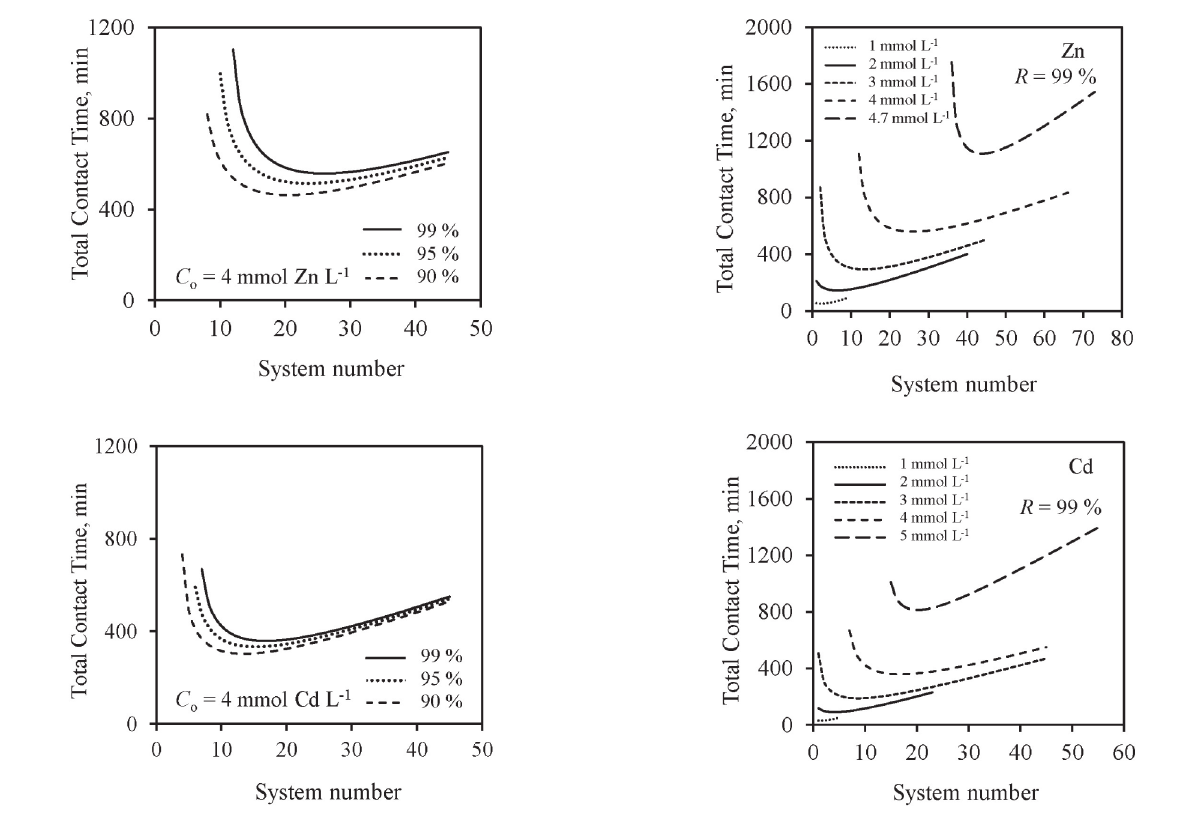
Fig. 9 – Minimum contact time to achieve 99 % removal of zinc and cadmium for various initial